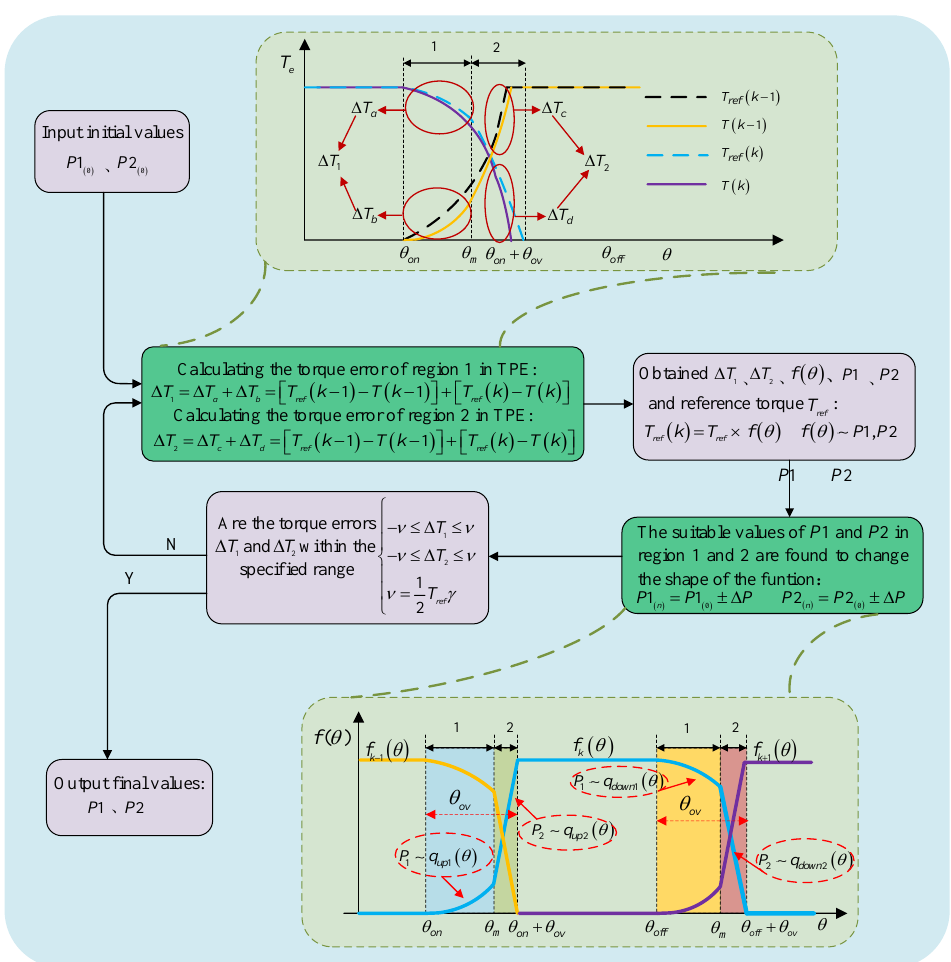
Figure 9. Optimization algorithm of torque sharing function. The torque errors of ∆𝑇 1 and ∆𝑇 2 in each region should be adjusted according to er- ror limit 𝑣 , which is set based on the desired rate of torque ripple 𝛾 . The limit formula is shown as Formula (10).